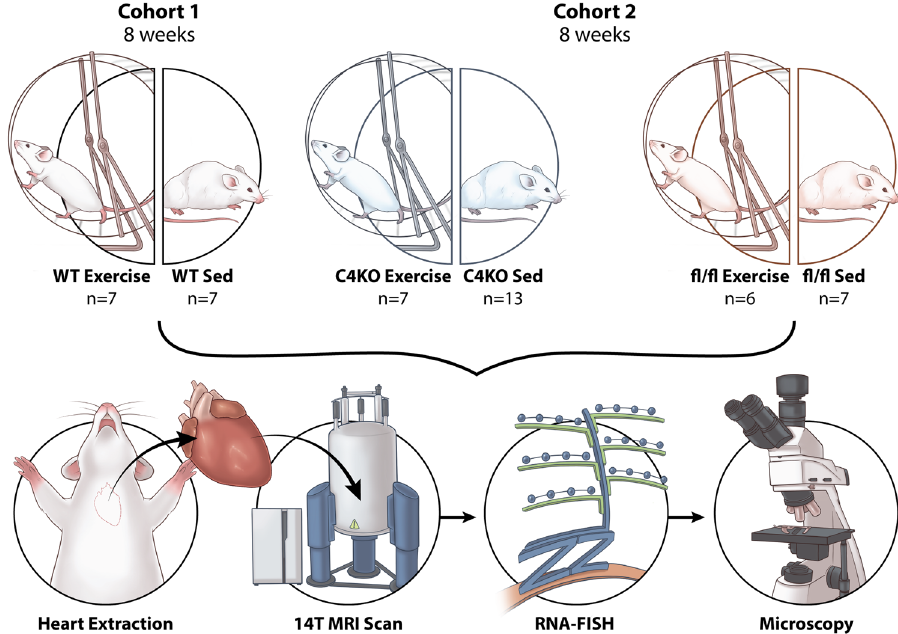
Fig. 1 Characterization of the experimental set-up. Cohort 1 consisted of wild-type sedentary ( n = 7) and wild-type exercise ( n = 7) mice. Cohort 2 included cardiomyocyte-speci fi c CITED4 knock out (C4KO) exercise ( n = 7), C4KO sedentary ( n = 13), fl / fl exercise ( n = 6) and fl / fl sedentary ( n = 7) mice. These groups were housed for 8 weeks, and the exercise group had free access to a running wheel. The hearts were perfused and excised after the 8-week holding period. The hearts were imaged using 14 T magnetic resonance imaging (MRI) followed by RNA-FISH of a whole axial slice of the left ventricle. These slides were imaged and analyzed with a fl uorescent light